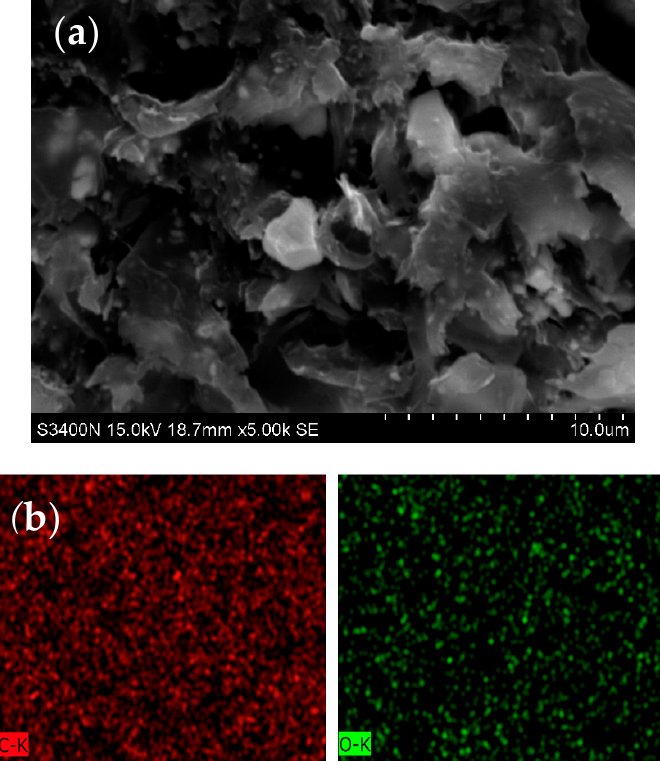
Figure 4. The SEM image of the graphene-loaded coating. ( a ) The micrograph of cross-section; ( b ) EDS images of carbon and oxygen. Table 4. Atomic compositions of the coatings with or without graphene from EDS results. Element Pristine Coating